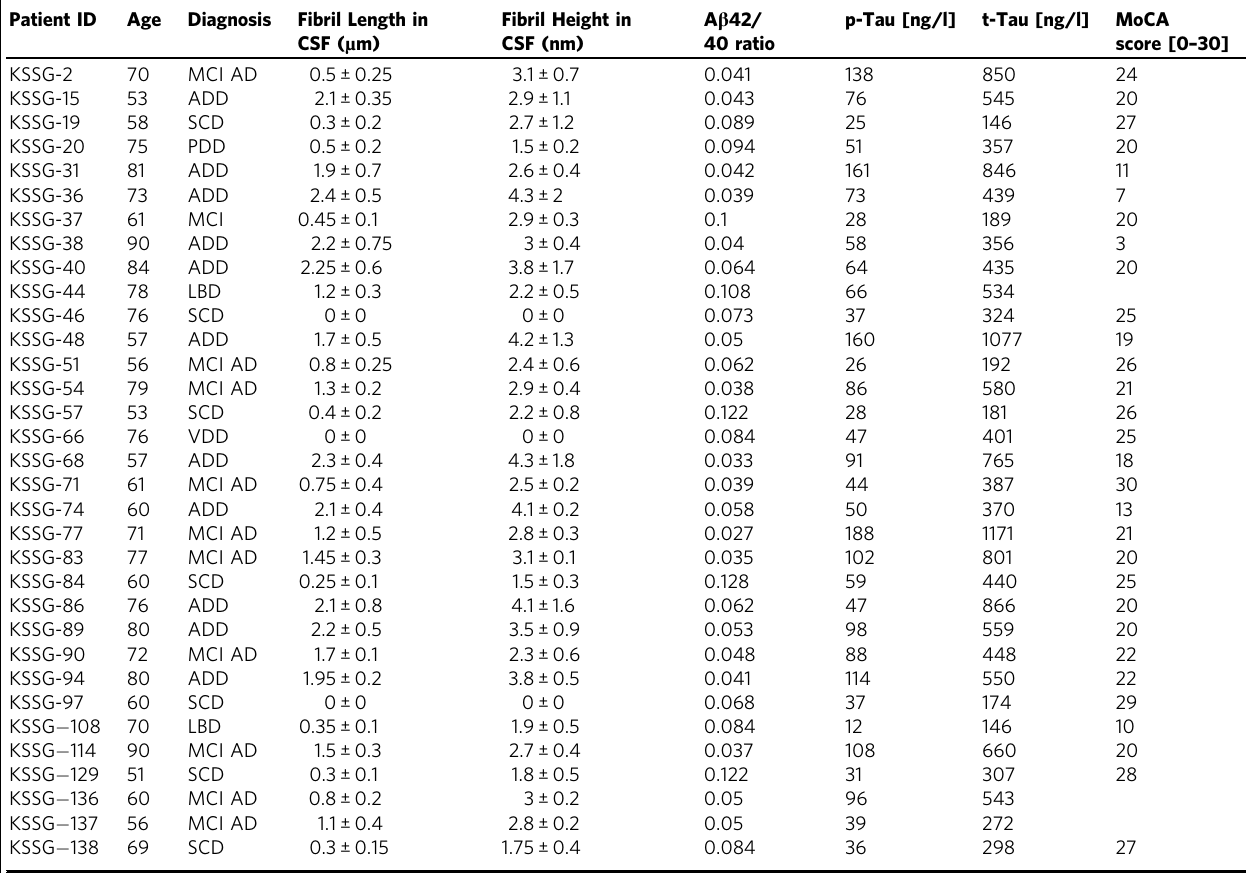
Table 1 Clinical data, mean fi bril height and length values obtained from AFM analysis of CSF of the studied patients. Patient